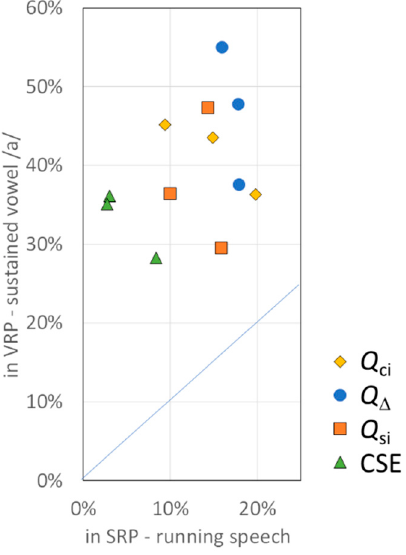
Figure 11. A comparison of variance explained by linear trends over Γ , for running speech (horizontal) and single vowel /a/ (vertical). Each marker represents a pair of group averages for one of the three participant groups in Figure 10. The aim of the figure is to show that for all the four EGG metrics shown, trends explain a much greater proportion of the total variance when producing only the /a/ vowel than in running speech. ( Q si is a metric of EGG pulse asymmetry.) (Previously unpublished data, collected for [18].)